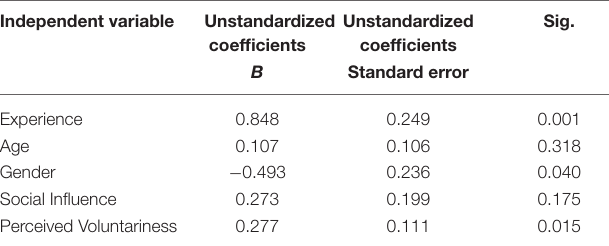
TABLE 6 | Linear regression of behavioral intention to use telepsychiatry on experience, age, gender, social influence, and perceived voluntariness of